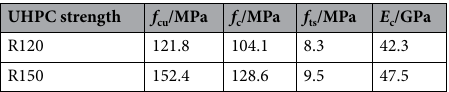
Table 3. Mechanical properties of UHPC.